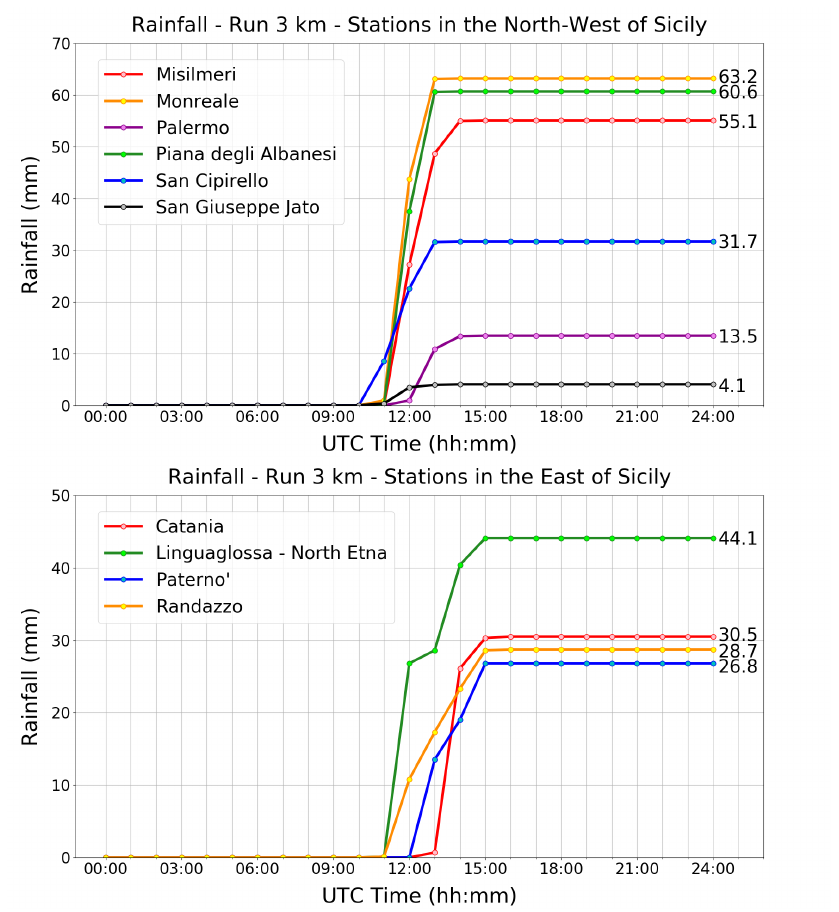
Figure 24. Cumulative rainfall predicted by the WRF model for the whole day of 15 July 2020, with a domain of 3 km and in correspondence of six stations placed in the western part of Sicily ( top ) and of four weather stations placed in the eastern part of Sicily ( bottom